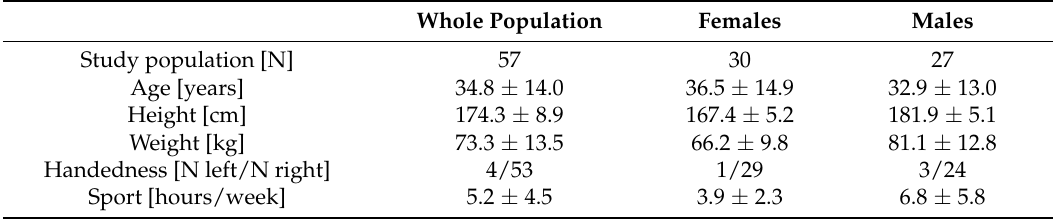
Table 1. Description of the study population, as a whole and broken down by sex. Results are displayed as value or as mean ± standard deviation